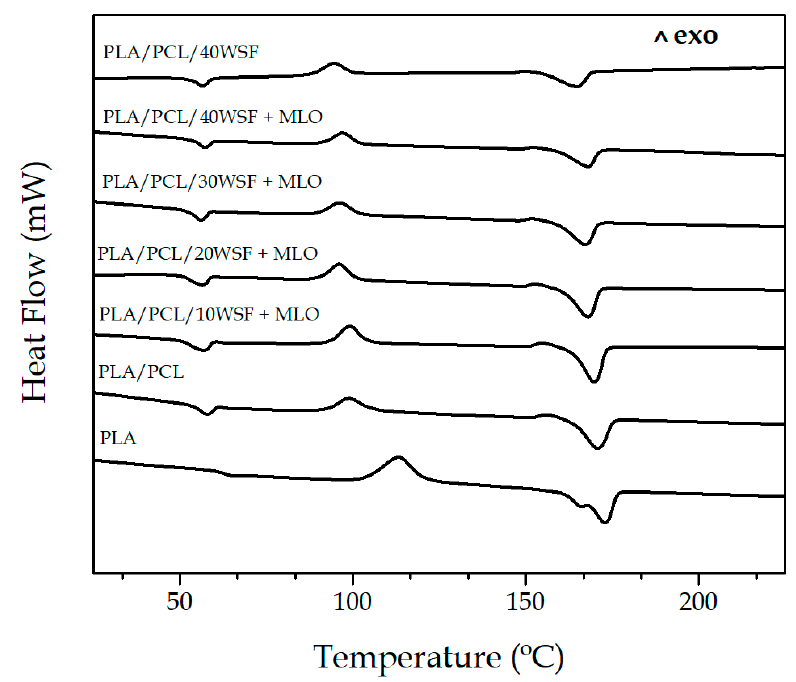
Figure 4. Differential scanning calorimetry (DSC) curves of the green composites made of polylactide (PLA), poly( ε -caprolactone) (PCL), walnut shell flour (WSF), and maleinized linseed oil (MLO). Table 3. Main thermal parameters of the green composites made of polylactide (PLA), poly( ε -caprolactone) (PCL), walnut shell flour (WSF), and maleinized linseed oil (MLO) in terms of: normalized enthalpy of cold crystallization ( ∆ H CC ), cold crystallization temperature (T CC ), normalized enthalpy of melting ( ∆ H m ), and melting temperature (T m ) for the PLA and PCL phases. Sample ∆ H m PCL T m PCL ( ◦ C) (J / g)